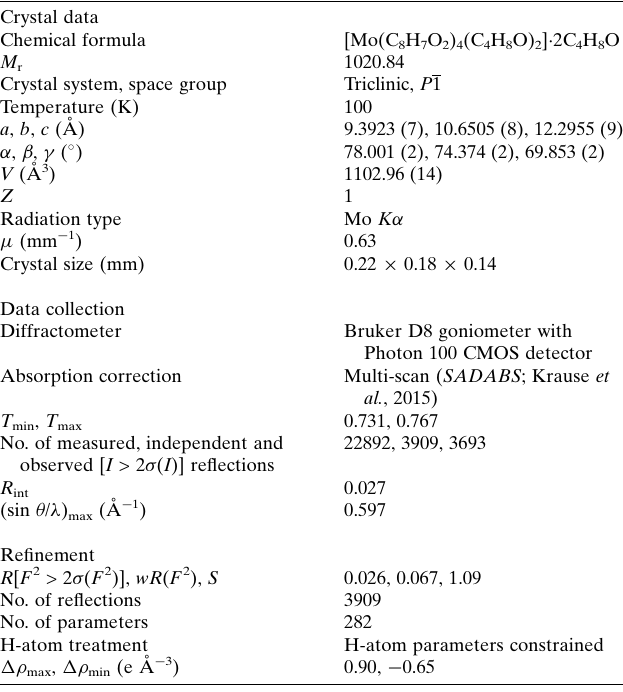
Table 2 Experimental